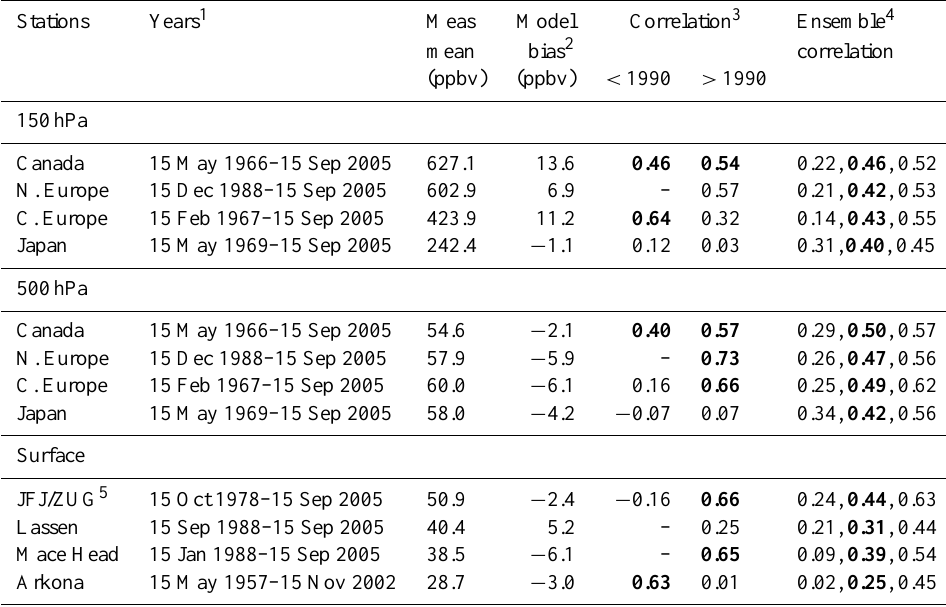
Table 2. Comparison between ensemble mean simulated and measured ozone over various regions or sites.